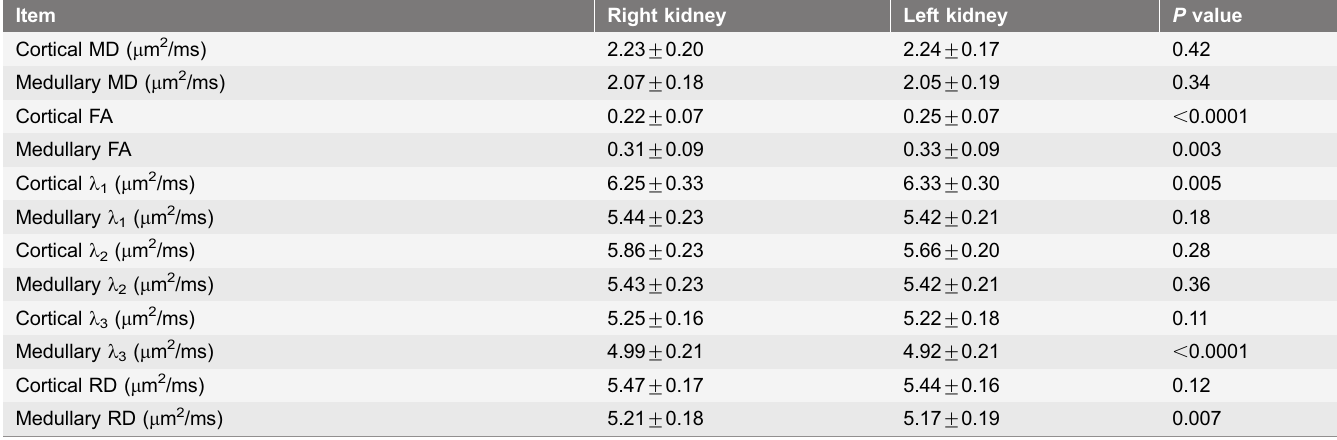
Table 3. DTI parameter index value by kidney.